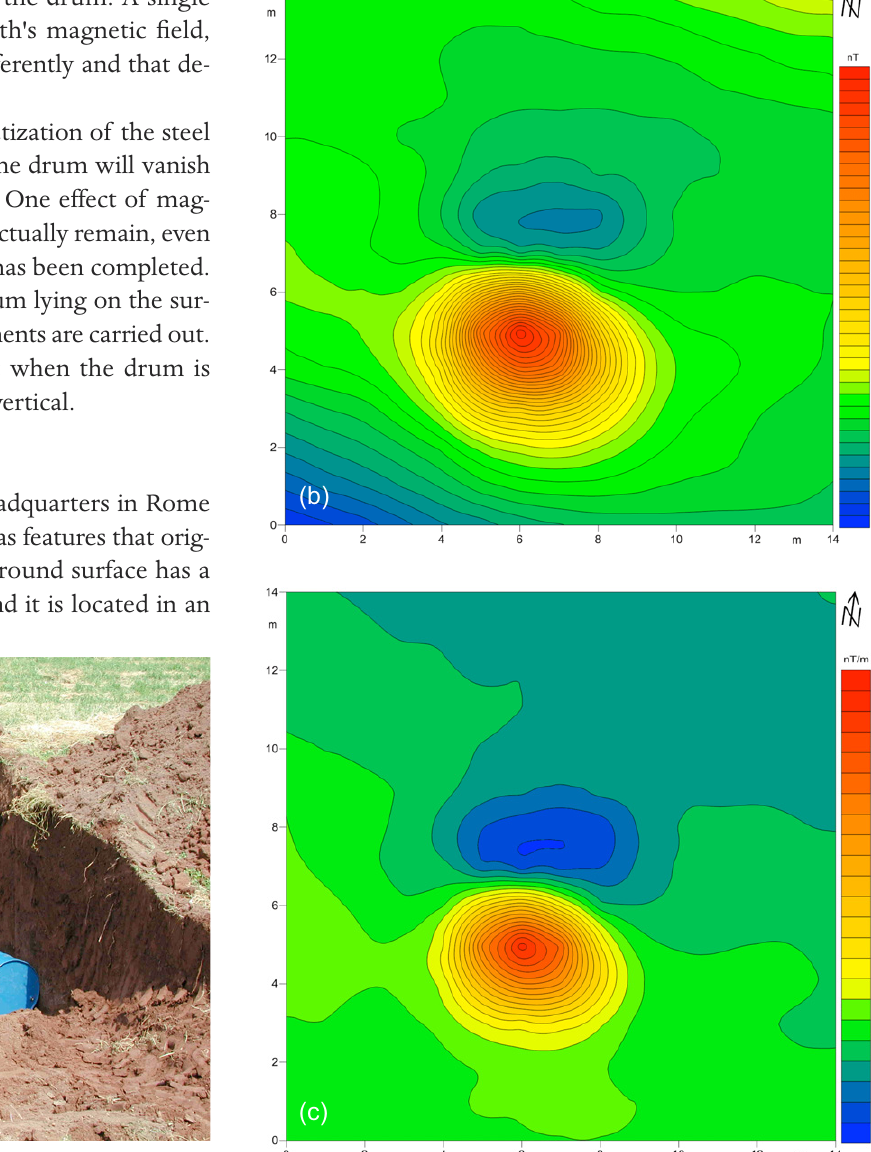
Figure 3. Three buried steel drums. The magnetic inclination was around 58º. (a) Photograph of the preparation of the underground target. (b) Anomaly map of the total intensity field. (c) Map of the vertical